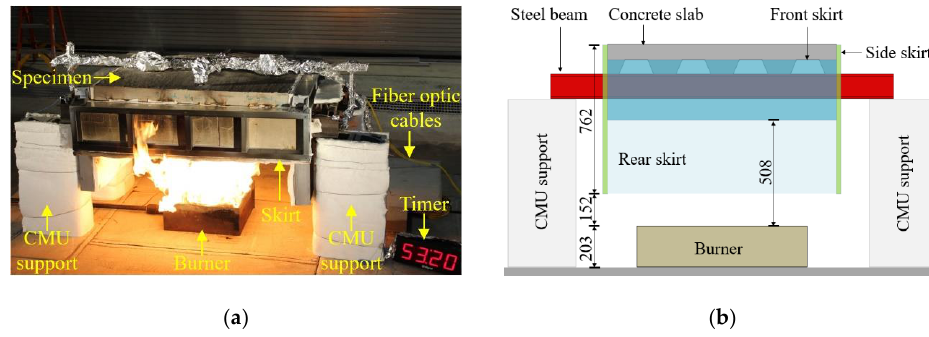
Figure 4. Test setup: ( a ) photograph, and ( b ) illustration (units in mm).